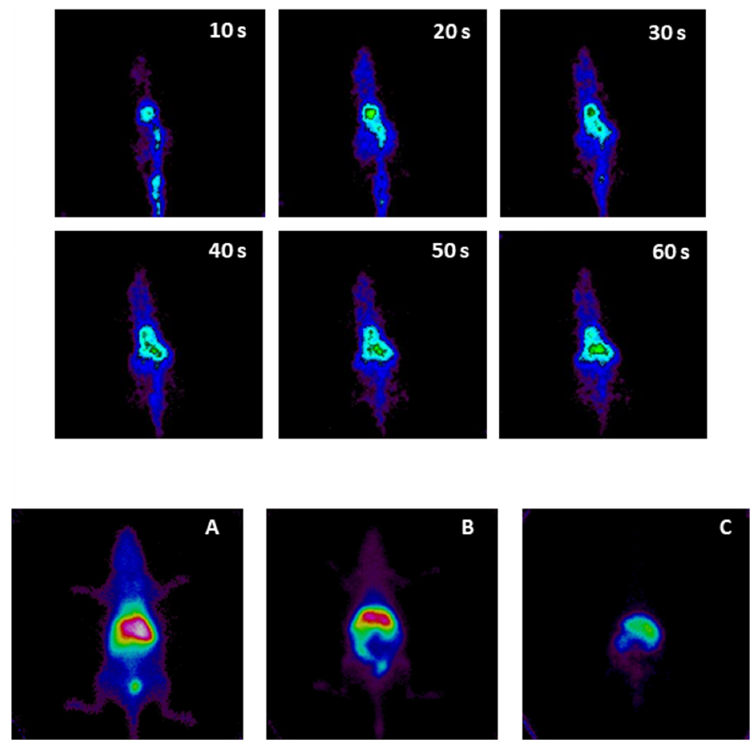
Figure 3. Biodistribution of TPGS micelles during the first minute after intravenous injection, as well as at 30 min ( A ), 3 h ( B ), and 24 h ( C ).